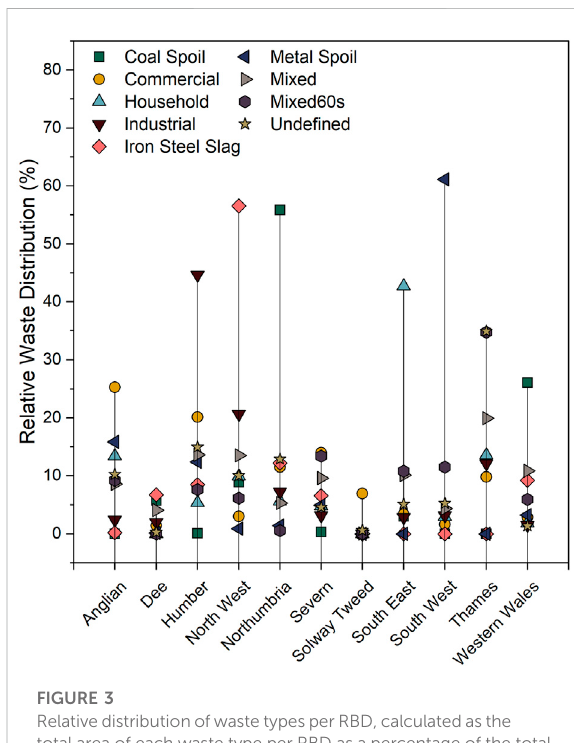
FIGURE 3 RelativedistributionofwastetypesperRBD,calculatedasthe total area of each waste type per RBD as a percentage of the total national area of each waste type in coastal regions of England and